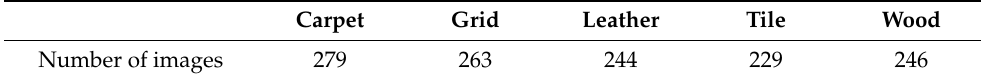
Table 2. Defect free texture images in the dataset. Carpet Grid Leather Tile Wood Number of images 279 263 244 229